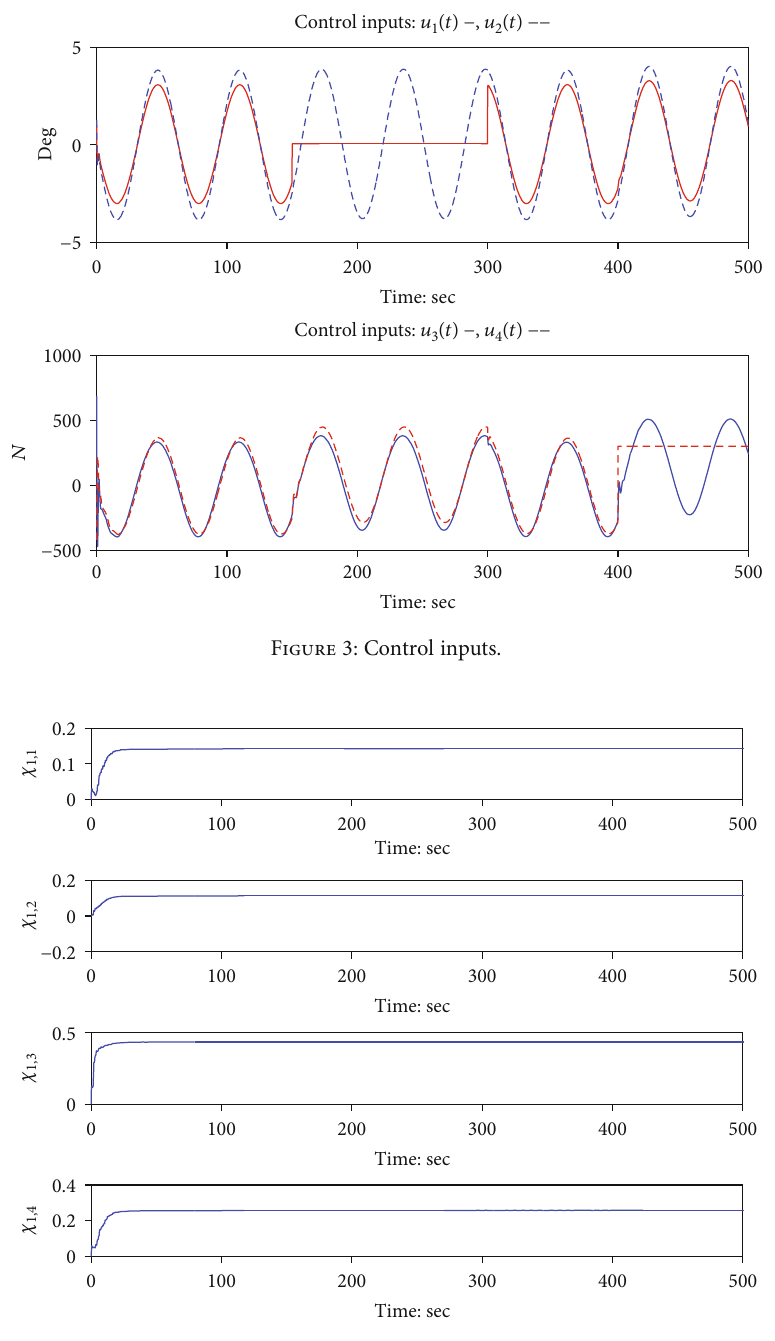
Figure 4: Parameter estimates χ